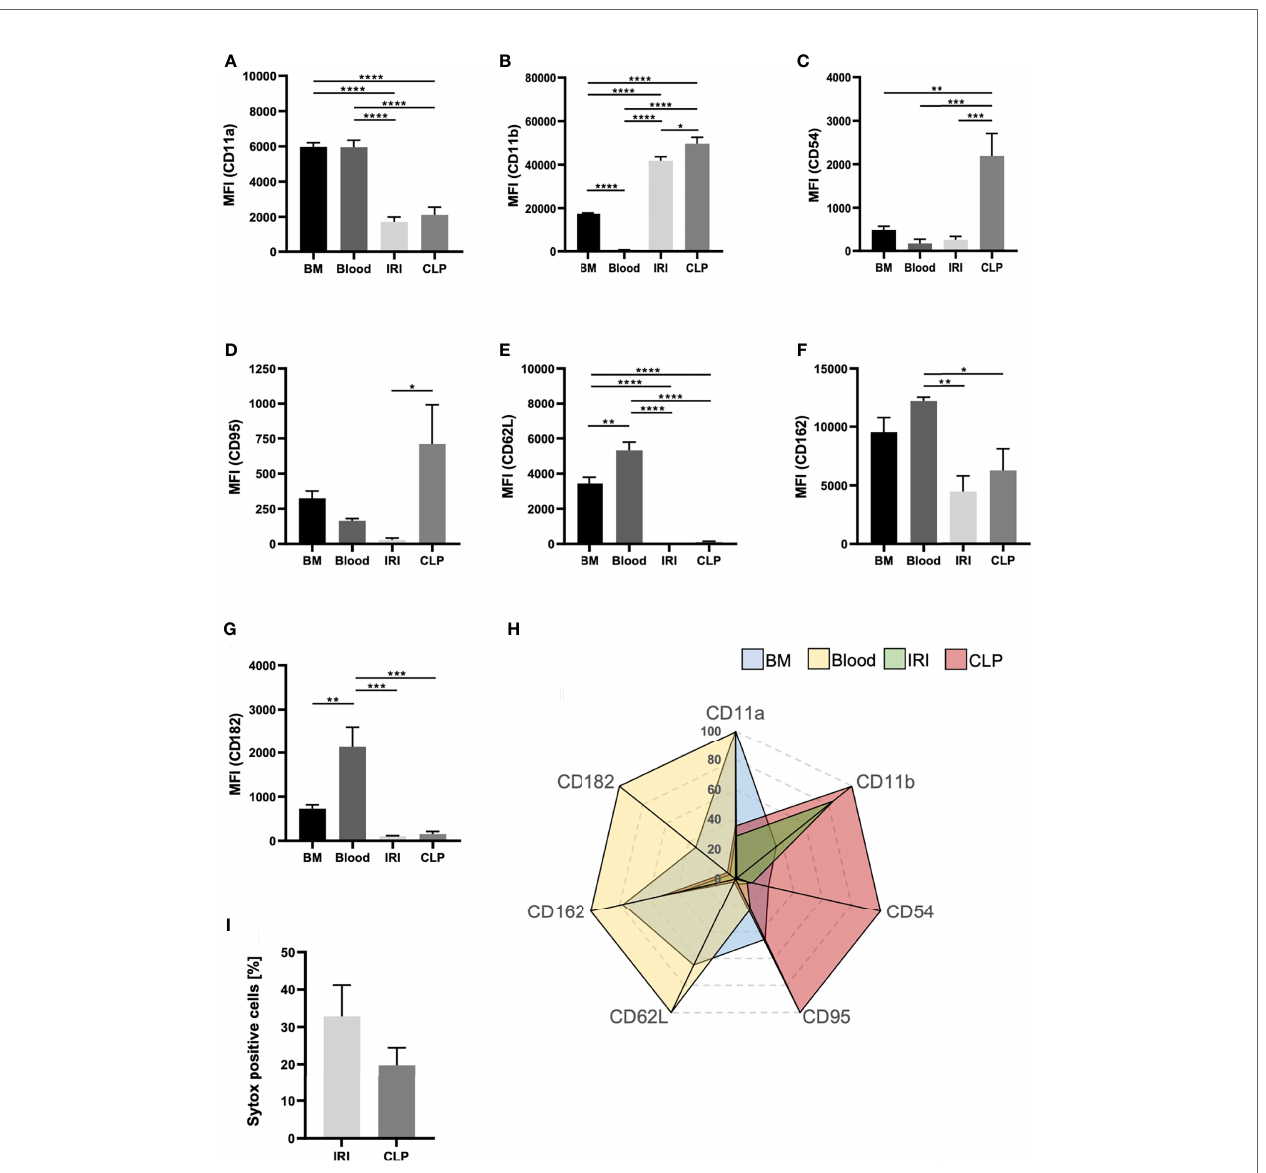
FIGURE 6 | The mode of AKI shapes the phenotype of recruited neutrophils. AKI was induced in WT mice via IRI or CLP. Transmigrated neutrophils, de fi ned as CD45 + Ly-6G + Ly-6B.2 + , from kidney tissue were analyzed for classical surface markers. Bone marrow and blood neutrophils were analyzed from healthy, adult WT mice. Mean fl uorescence intensities (MFIs) of CD11a (A) , CD11b (B) , CD54 (C) , CD95 (D) , CD62L (E) , CD162 (F) and CD182 (G) on bone marrow-, blood- IRI- and CLP-derived neutrophils were determined by fl ow cytometry (n = 5). Sytox positive cells are shown in percentages of total cells (H) (n = 5). Clustering of neutrophil phenotype is displayed in a radar plot (I) . Data are mean ± SEM. ****p < 0.0001, ***p < 0.001, **p < 0.01, *p <